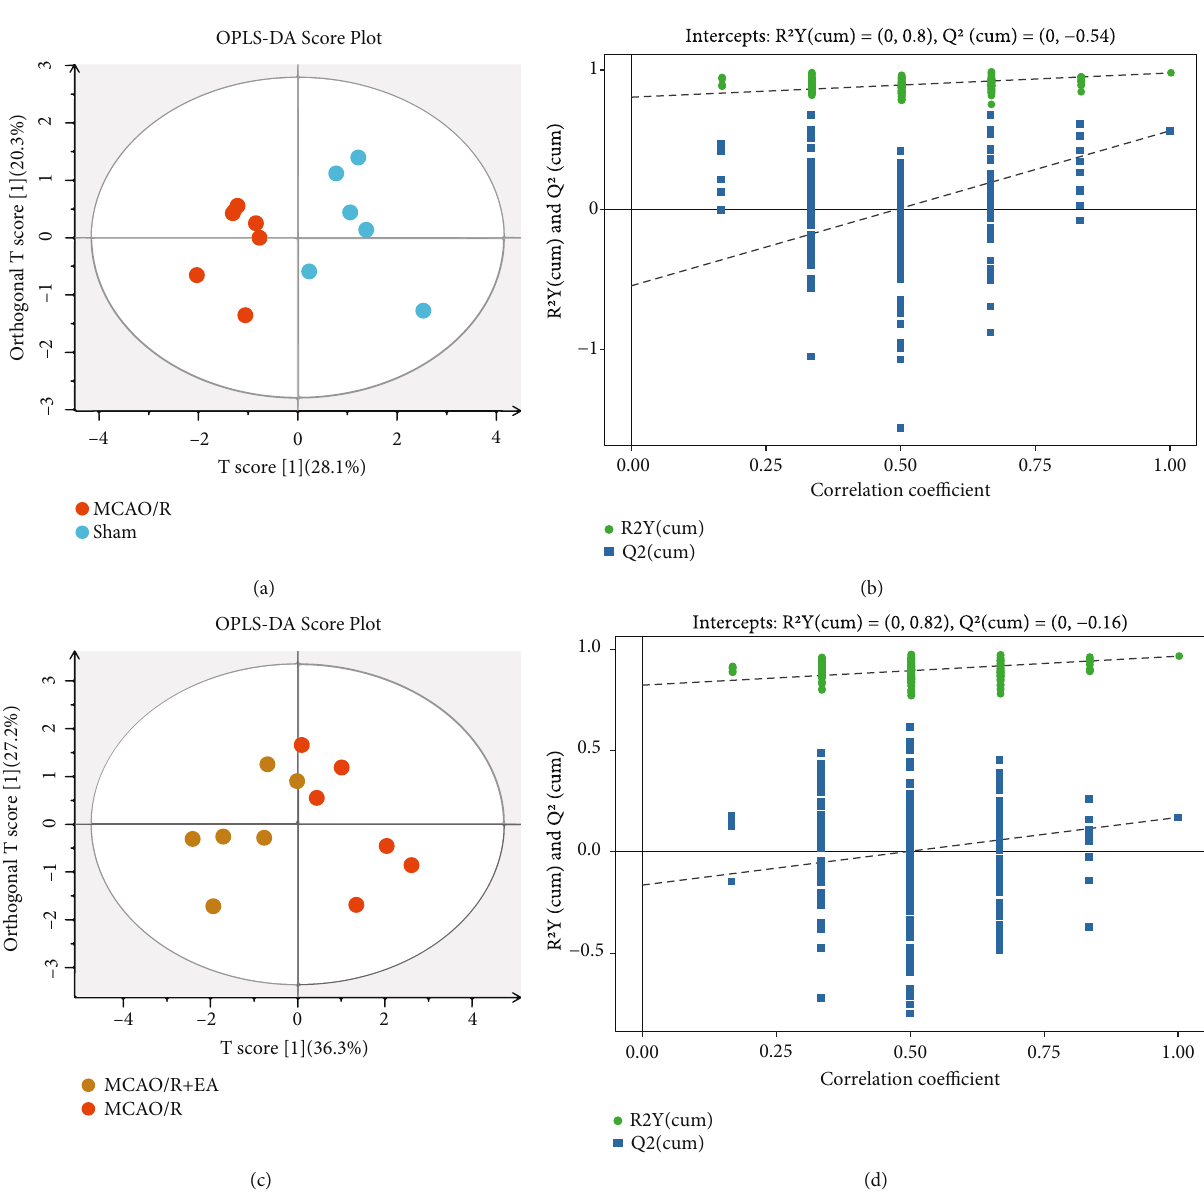
Figure 6: Score scatter plot and permutation test of the OPLS-DA model. (a), (c) OPLS-DA score plots of the MCAO/R group vs. the sham group ( X interpretationrate = 0 : 485 , Y interpretation rate = 0 : 978 , and Y predictionrate = 0 : 564 ) and the MCAO/R+EA group vs. the MCAO/R group ( X interpretation rate = 0 : 635 , Y interpretation rate = 0 : 965 , and Y prediction rate = 0 : 170 ). (b), (d) Permutation test plots of MCAO/R group vs. sham group ( intercept of regression cure of Y interpretation rate = 0 : 80 and intercept of regression curve of Y predictionrate = − 0 : 54 ) and MCAO/R+ EA group vs. MCAO/R group ( intercept of regression cure of Y interpretation rate = 0 : 82 and intercept of regression curve of Y prediction rate = − 0 : 16 ). Abbreviations: EA: electroacupuncture; MCAO/R: middle cerebral artery occlusion-reperfusion; OPLS-DA: orthogonal projections to latent structures-discriminant